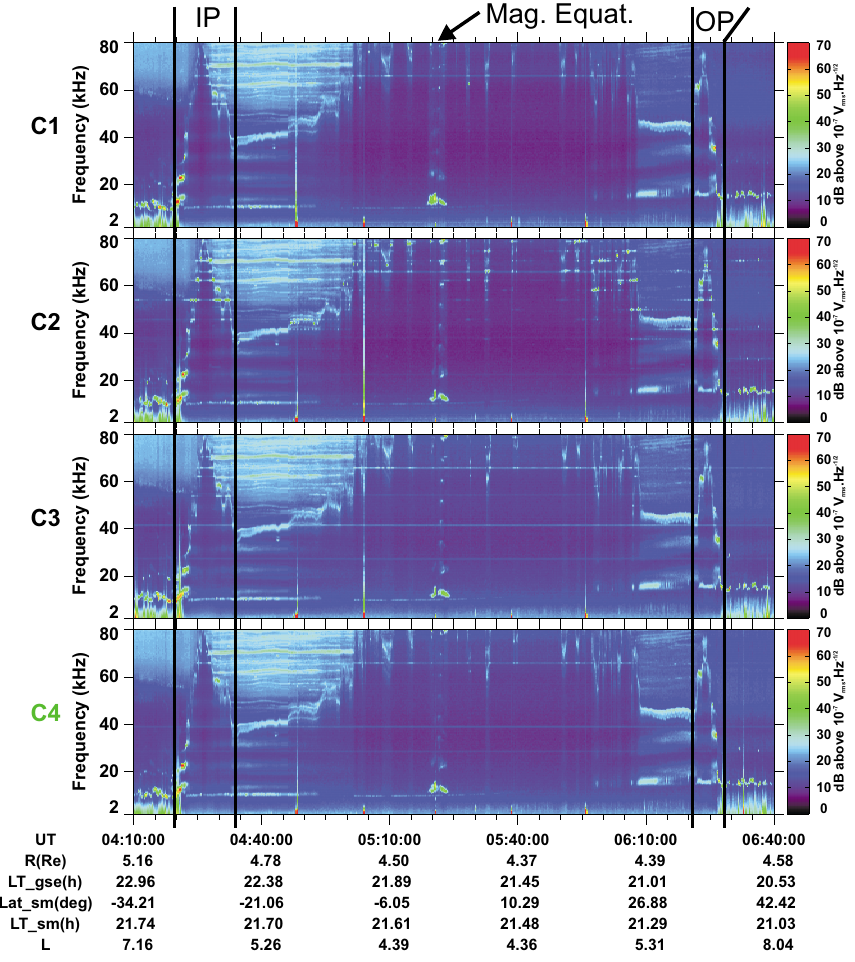
Fig. 14. Frequency-time spectrograms measured by the four CLUSTER/WHISPER instruments on 11 April 2002, showing the entire plasmasphere crossing, including plume traversals in the inbound (IP) and outbound passes (OP) and the magnetic equator (Mag. Equat.) crossed at 05:20 UT. The orbital parameters correspond to